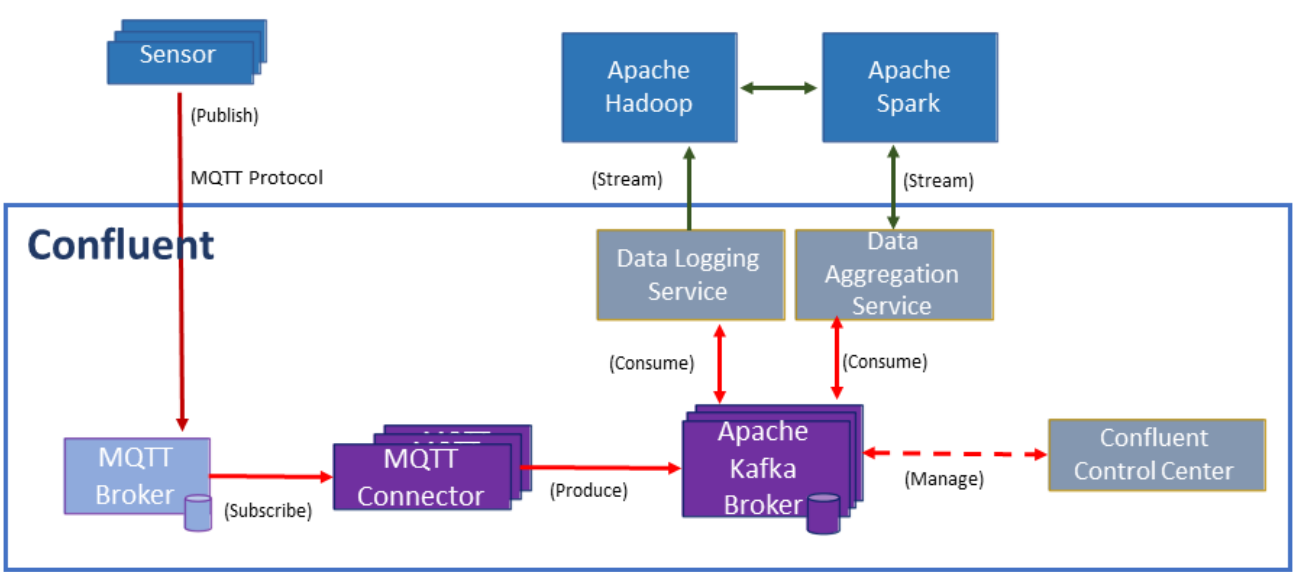
Figure 8. The high-level architecture of a typical IoT system that combines MQTT and Apache Kafka, Figure 8. The high ‐ level architecture of a typical IoT system that combines MQTT and Apache and confluent manages all the elements of MQTT and Apache Kafka, and confluent manages all the elements of MQTT and Apache Kafka.